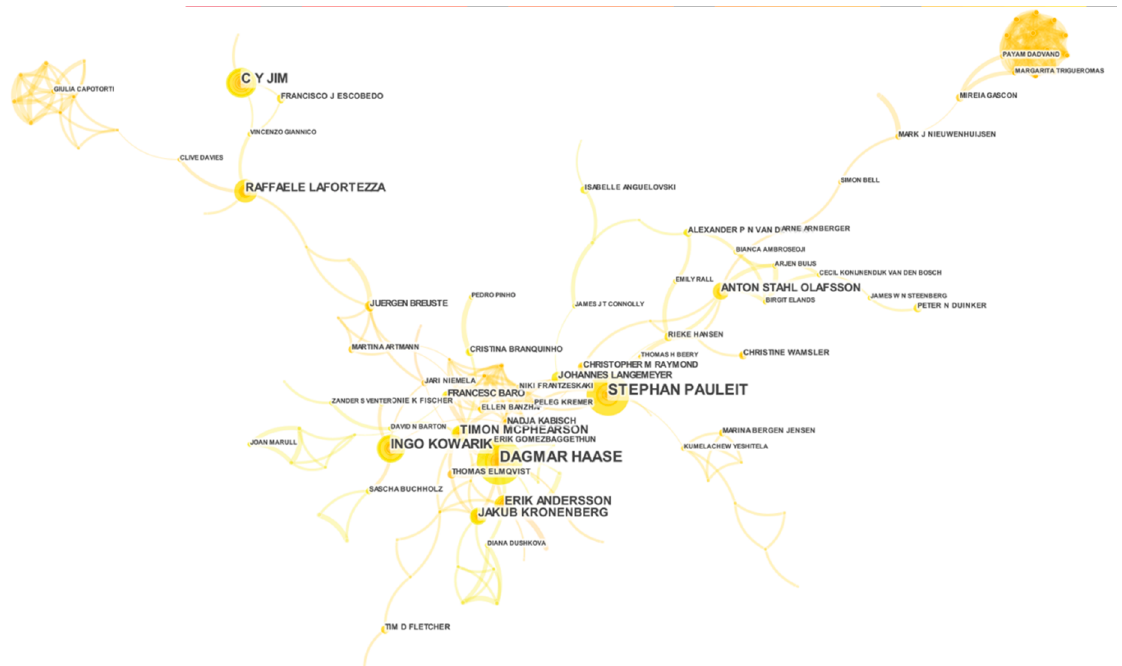
Figure 10. Author co-occurrence network.